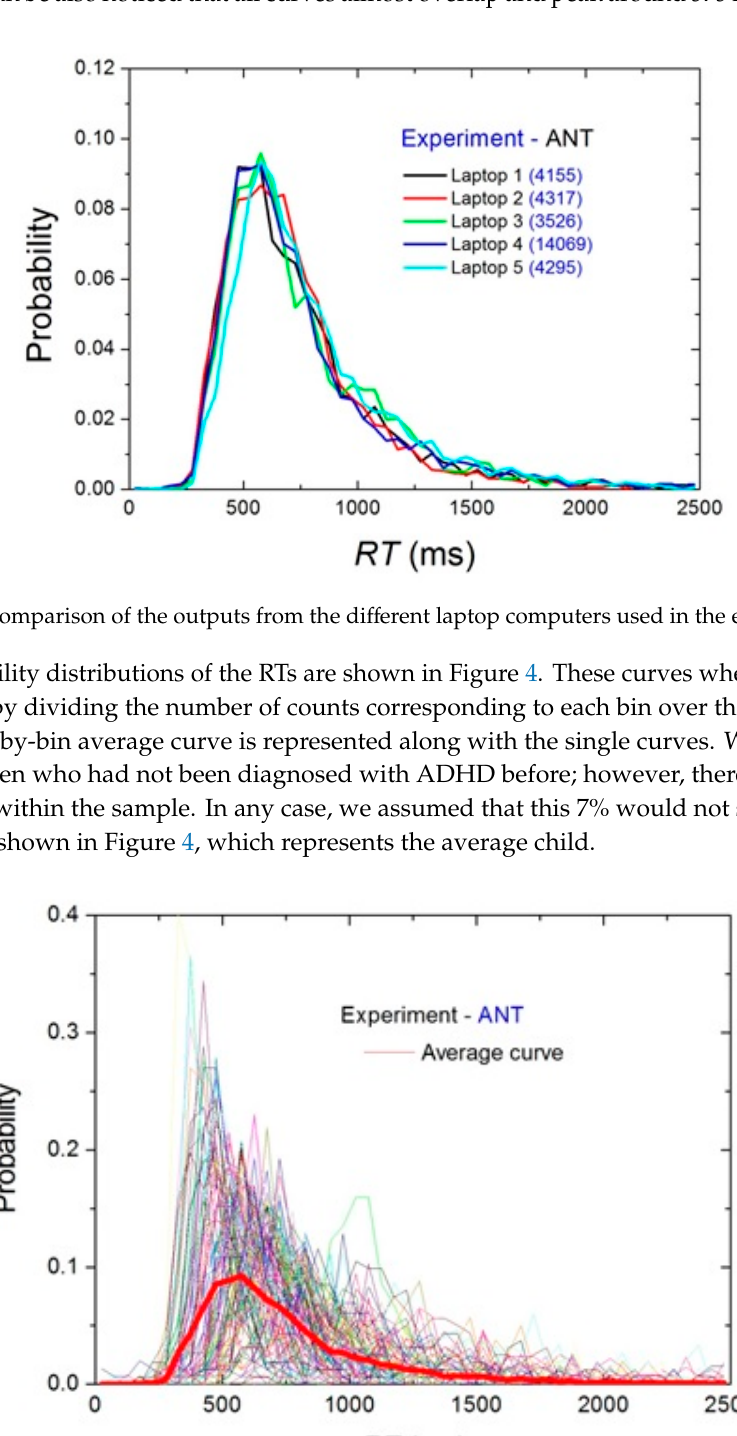
Figure 4. Probability distributions and average curve.